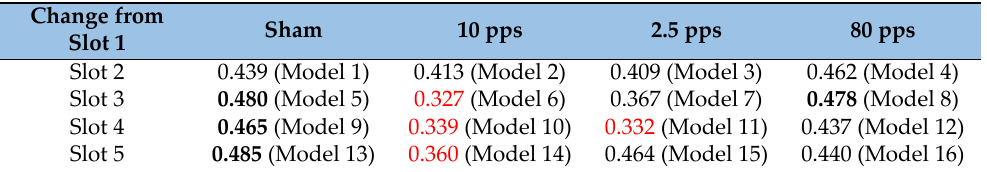
Table 6. Confusion matrix results ( kappa ) for the 16 models in Phase 1. Values in bold are in the upper quartile of all 16 values, and those in red in the lower quartile. Change from Slot 1